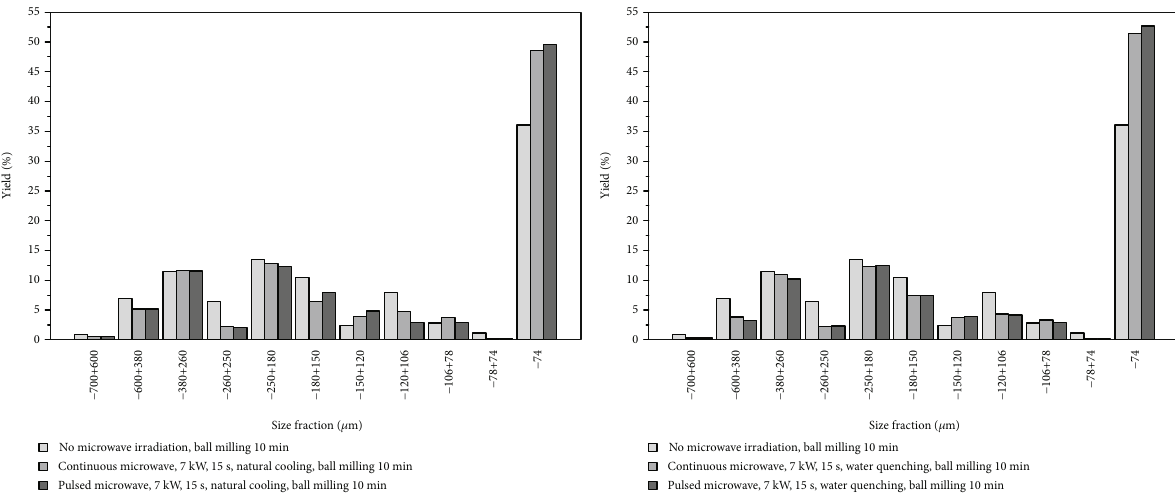
Figure 10: Comparison diagrams of the size fraction distribution of grinding products under natural cooling and water quenching after continuous and pulsed microwave